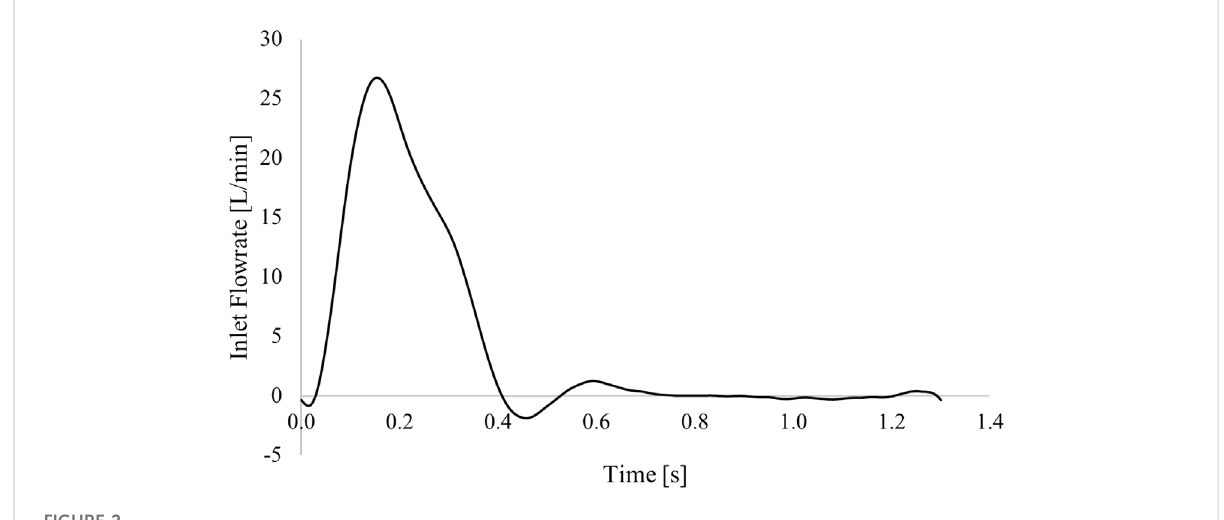
FIGURE 2 Inlet fl ow rate applied in the